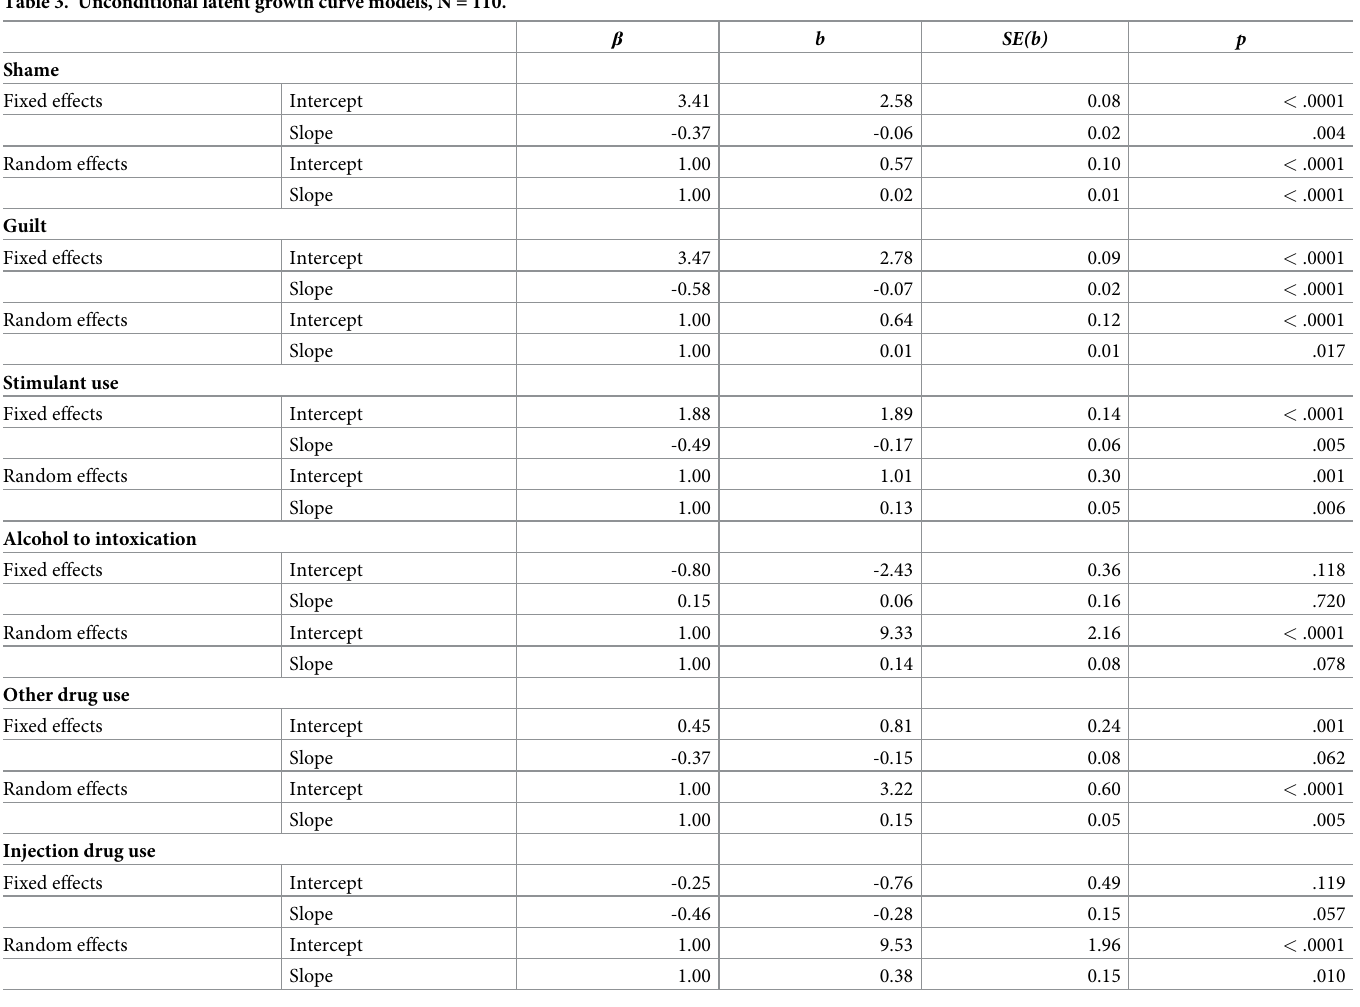
Table 3. Unconditional latent growth curve models, N =